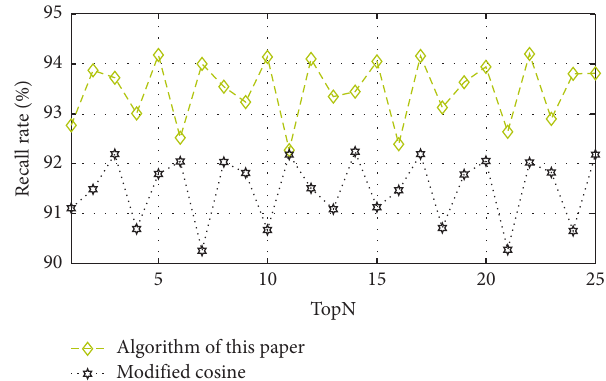
Figure 10: Comparison of recall rates of different similarity